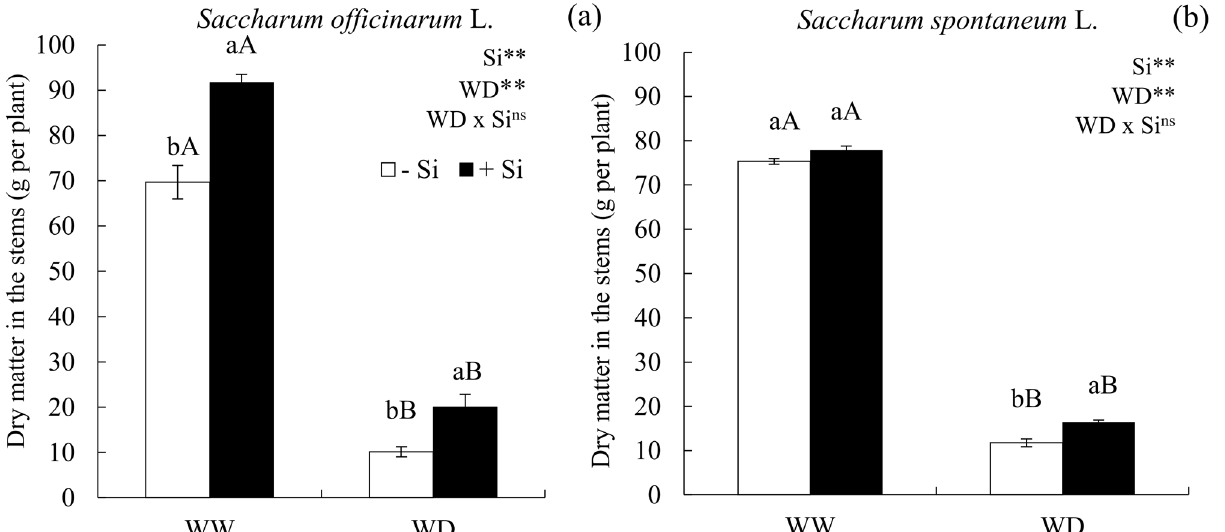
Figure 5. Dry matter of stems of ratoon of sugarcane ( Saccharum officinarum L.) ( a ) and energy cane ( Saccharum spontaneum L.) ( b ) cultivated without water deficit-WW (70% of soil water retention capacity— WRC) and with water deficit-WD (30% of WRC) without (− Si) and with (+ Si) application of Si via fertigation associated with leaf spray. ** and *: significant at 1 and 5% probability, respectively; and ns not significant for main effects and interaction, by the F-test. Lowercase letters show differences in relation to Si and uppercase letters in relation to WD. Bars represent the standard error of the mean. Si × WD: